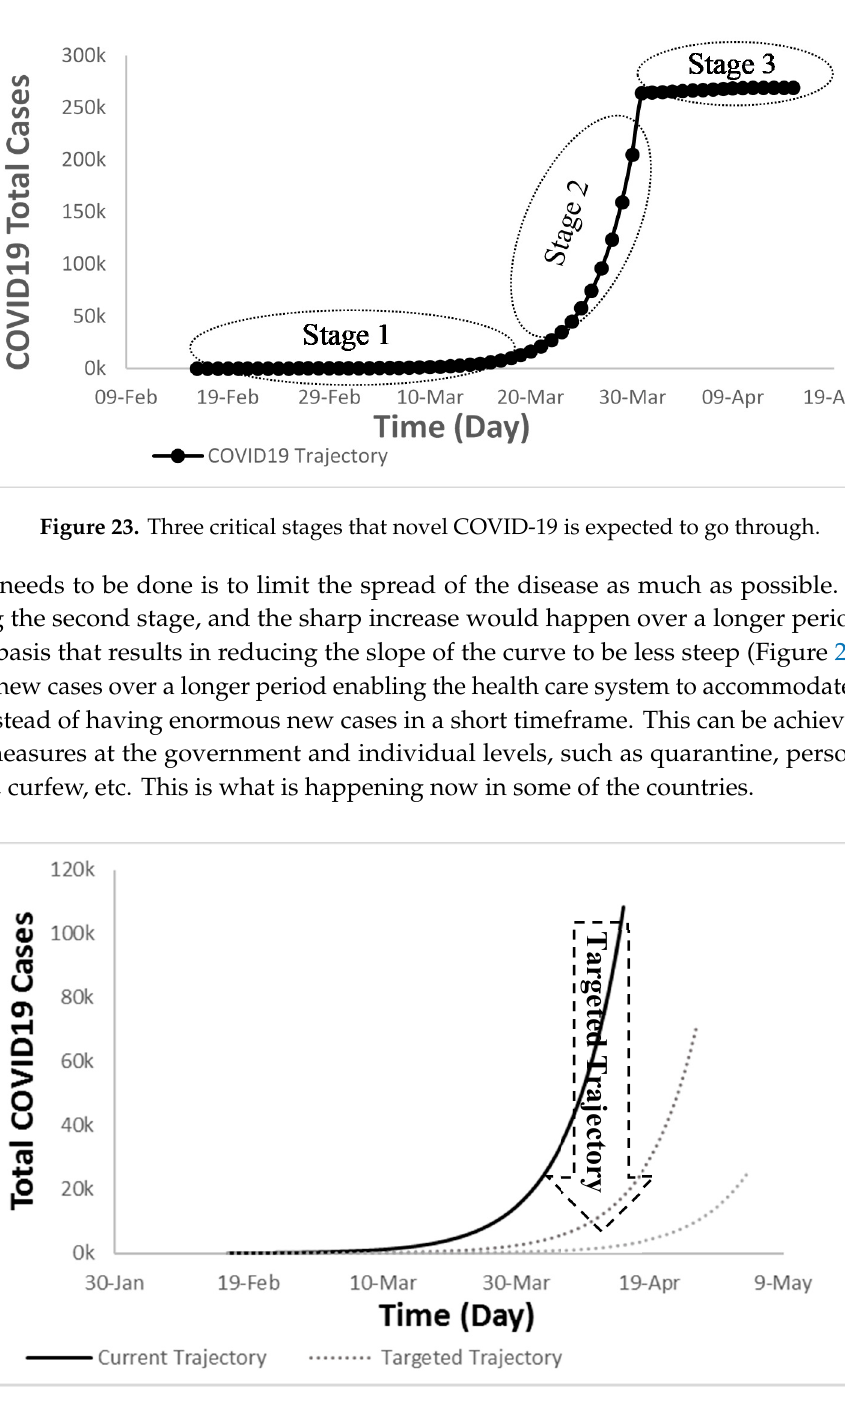
Figure 24. Targeted trajectory of COVID-19 as opposed to the current one.